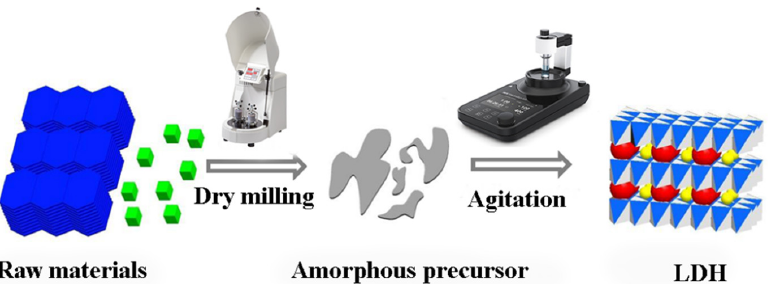
Figure 6. Illustration of two-step dry grinding and agitation in the water process operation. Reproduced with permission from [12]. Copyright Elsevier, 2017.